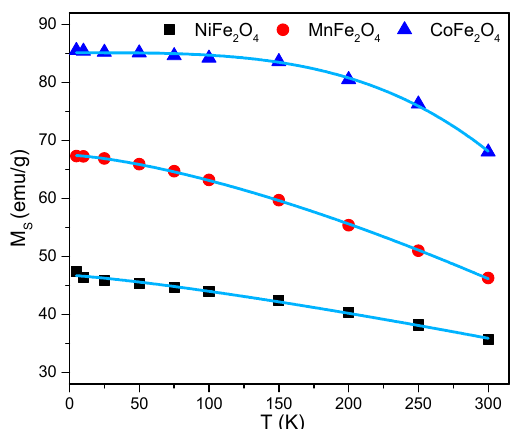
Figure 3. Saturation magnetizations as a function of temperature for nickel, manganese, and cobalt ferrites. The lines represent the best fits obtained with the Bloch equation.